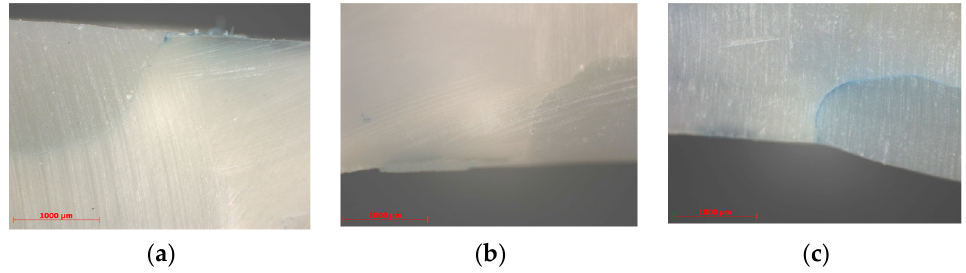
Figure 1. Optic microscope images of microleakage at cervical interface (50 X magnification). ( a ) Cervical microleakage score 1 subgroup B; ( b ) Cervical microleakage score 0 subgroup D; ( c ) Cervical microleakage score 3 subgroup D.